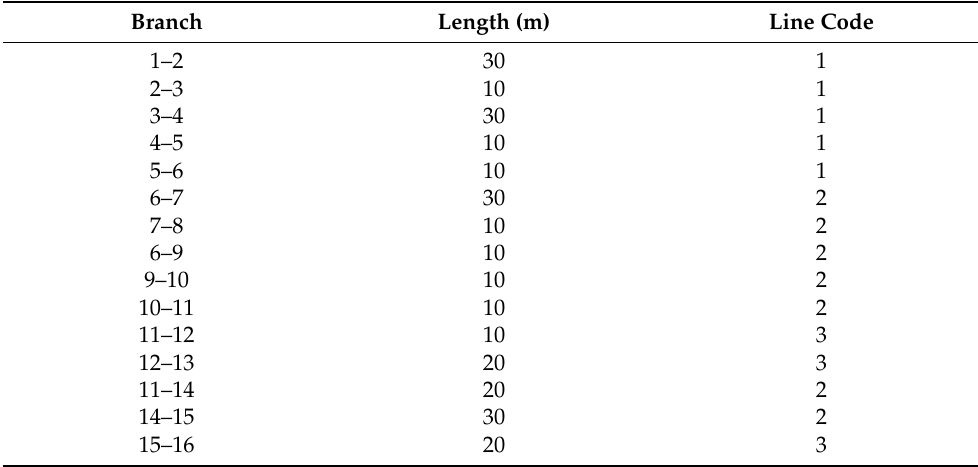
Table 2. Network branch data.